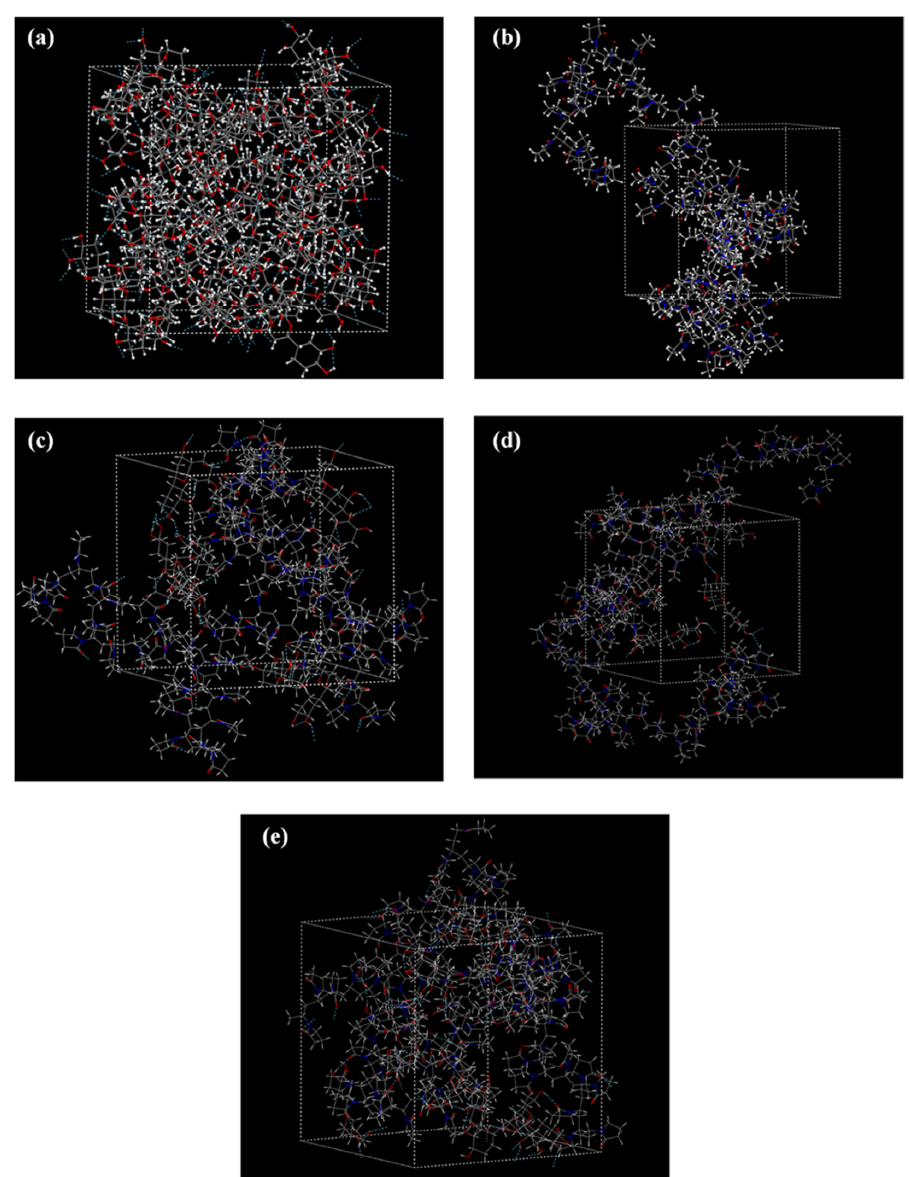
Figure 8. H-bond patterns in ( a ) amorphous LUT, ( b ) amorphous PVP, ( c ) LUT–PVP 10/90 w / w , ( d ) 20/80 w / w, and ( e ) 30/70 w / w ASDs. (H-bonds are depicted with cyan dashed lines.)